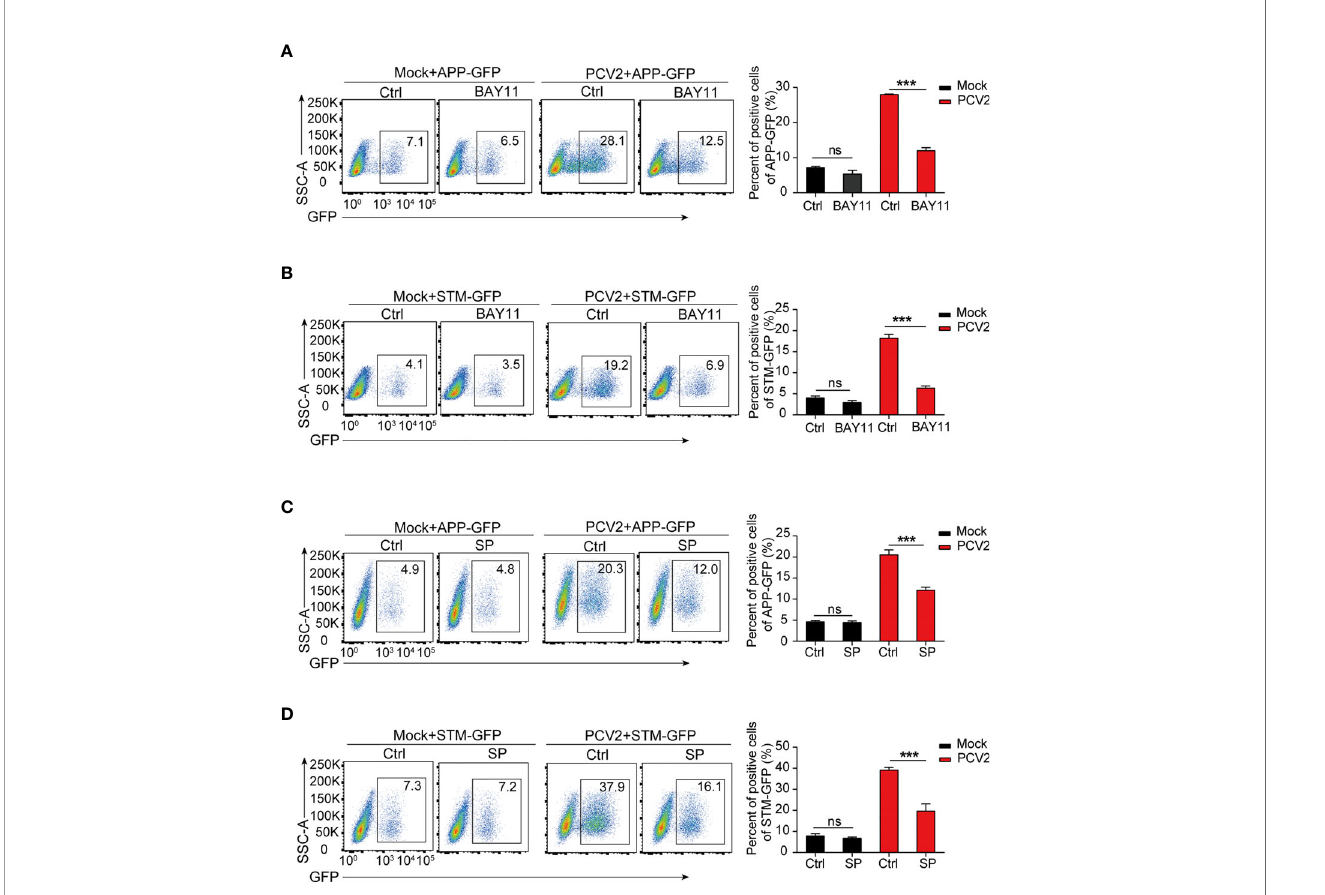
FIGURE 6 | PCV2-enhanced bacterial infection depends on M1-polarized macrophages. (A – D) Flow cytometry analysis of GFP positive cells in BMDMs infected with APP-GFP or STM-GFP alone for 3 h or pretreated with NF- k B inhibitor (BAY11, 10 m M) or JNK inhibitor (SP: SP600126, 10 m M) for 1 h followed by APP-GFP or STM-GFP infection for another 3 h or infection with PCV2 for 12 h before APP-GFP or STM-GFP infection. ns, not signi fi cant; *** P < 0.001 (Student ’ s t